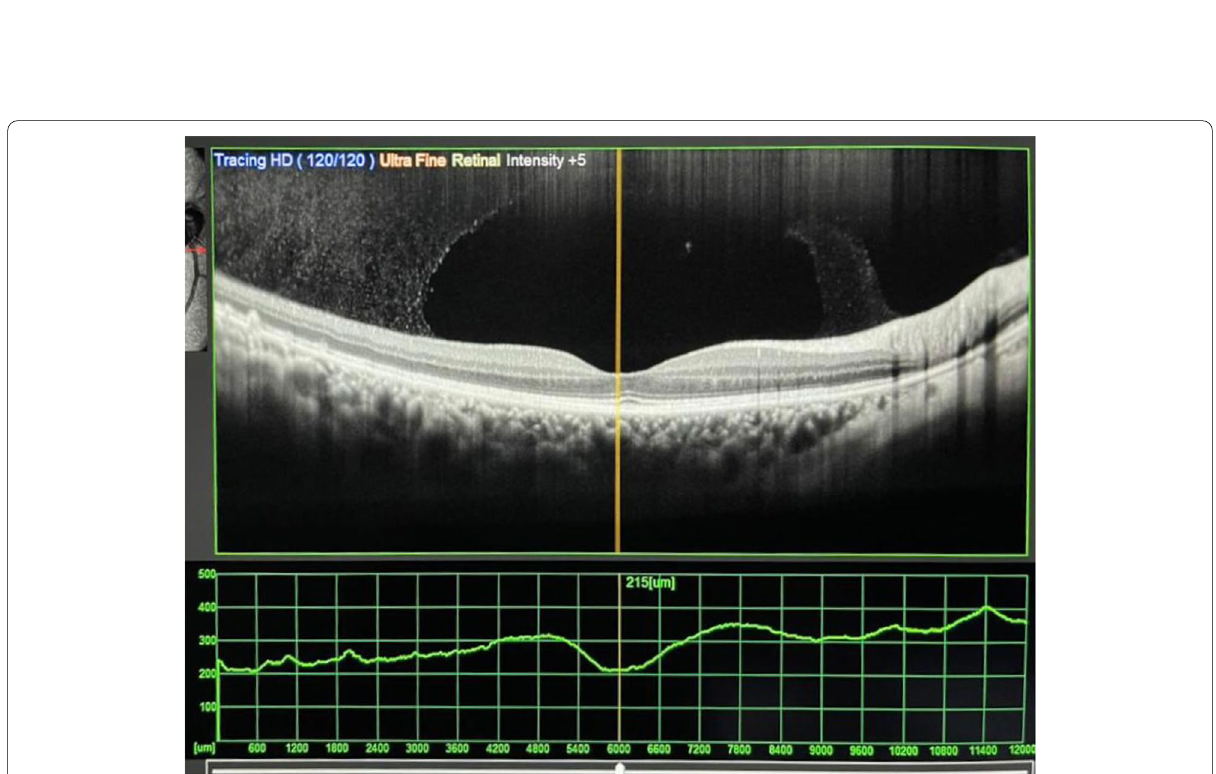
Fig. 4 Ocular coherence tomography of the right eye showing intact retinal pigmentary